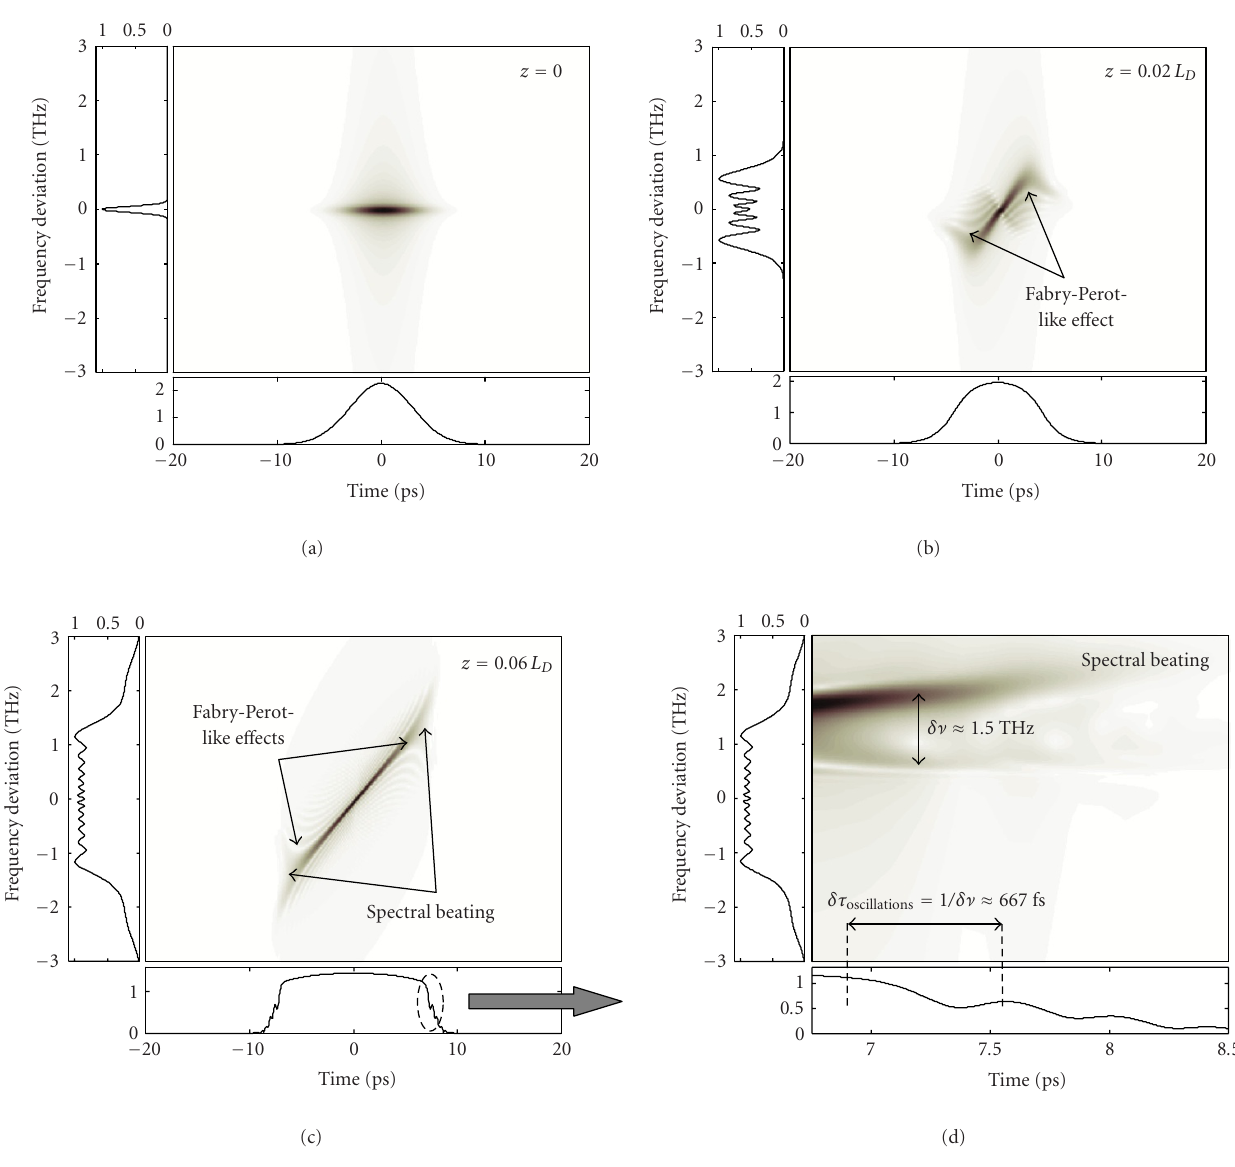
Figure 6: Wigner analysis of nonlinear pulse propagation through an optical fiber in the normal dispersion